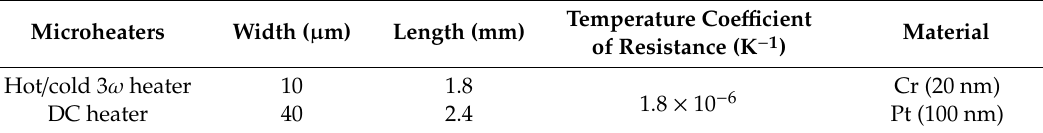
Table 1. Details of hot / cold 3 ω and direct current (DC) heaters.